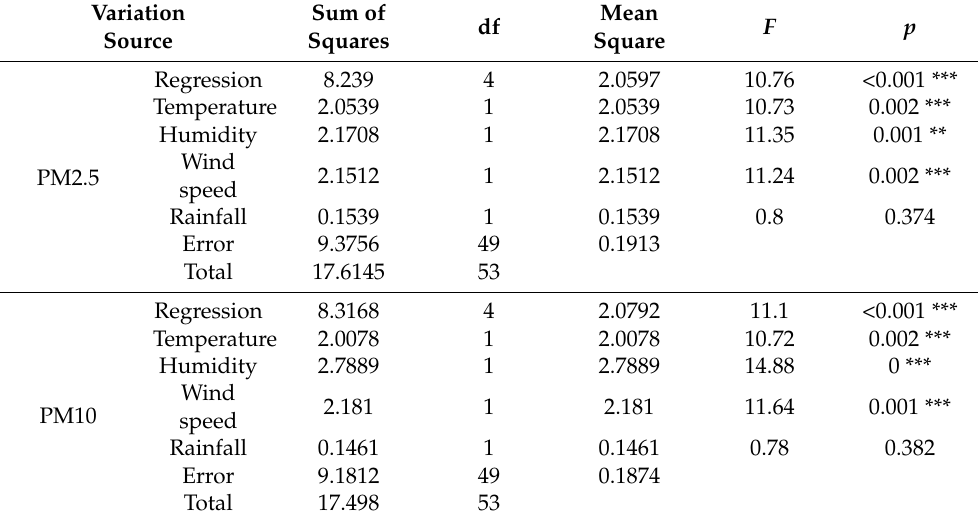
Table 3. Linear regression analysis of variance of PM2.5 and PM10 release concentration. Variation Sum Source